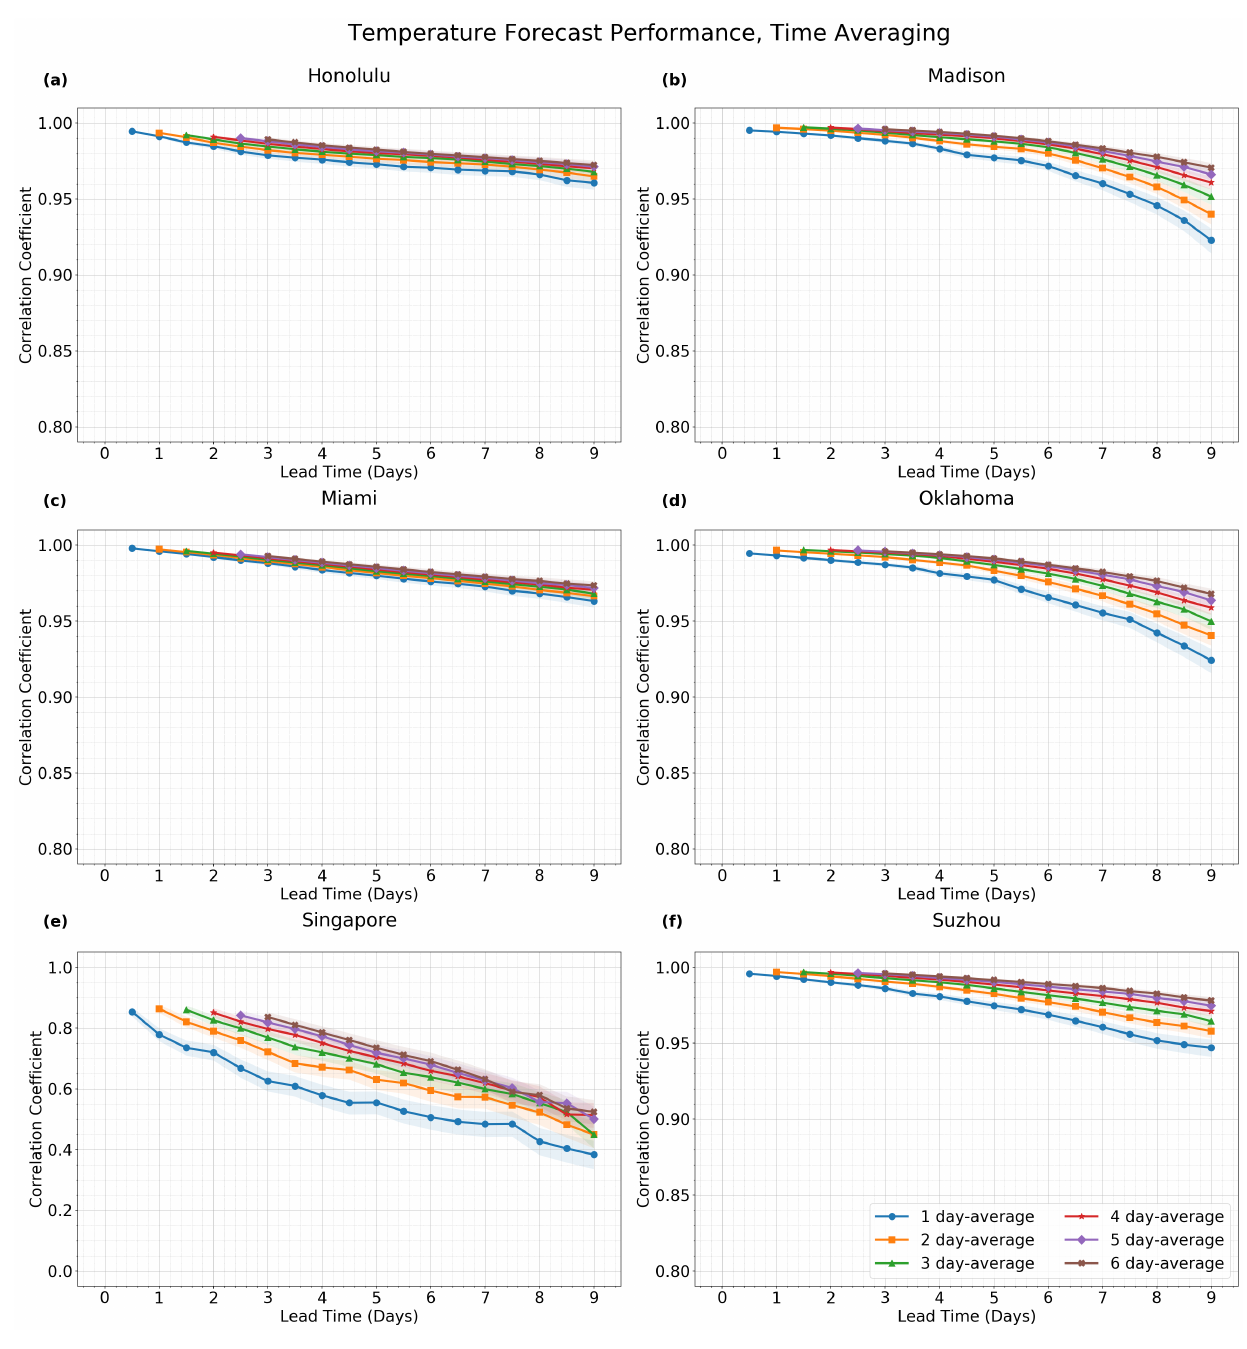
Figure 3. Effects of time averaging on forecast performance, for surface temperature, with 100-km spatial averaging, at several locations around the globe: ( a ) Honolulu, Hawaii (21 ◦ N, 158 ◦ W), ( b ) Madison, Wisconsin (43 ◦ N, 89 ◦ W), ( c ) Miami, Florida (26 ◦ N, 80 ◦ W), ( d ) Oklahoma City, Compare to the effects of spatial averaging from Figure